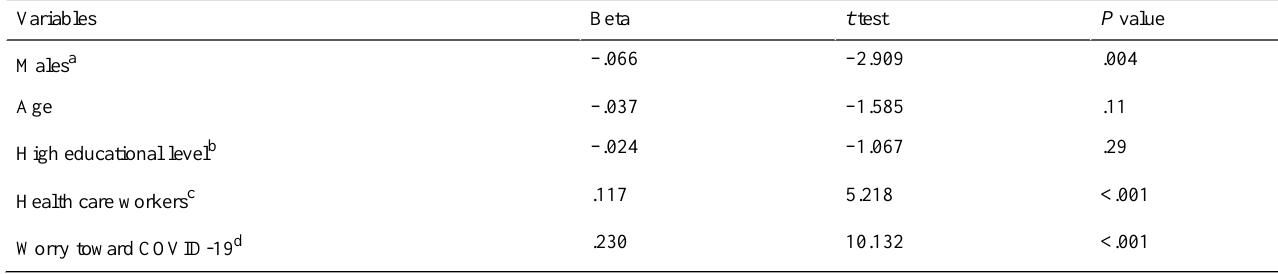
Table 3. Factors related to number of COVID-19 information